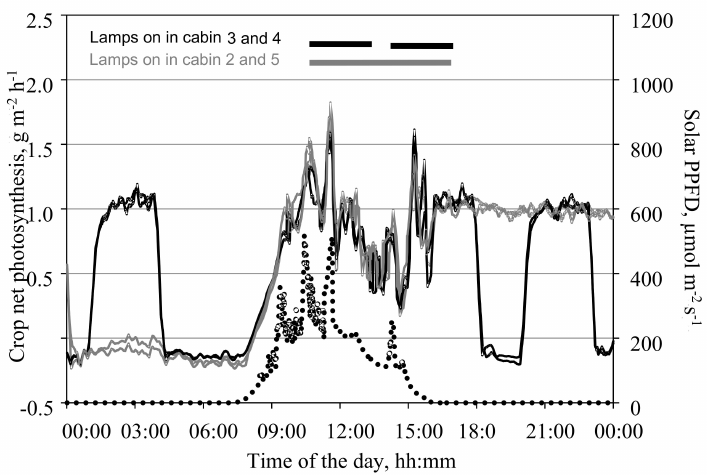
Figure 9. Daily course of net photosynthesis of a tomato crop measured in the open chamber mode and PPFD on the top of the crop on 24 November 2015 under two di ff erent light regimens. Data shows measurements taken in 9-min intervals. Leaf area index was 1.4 m 2 m − 2 . CO 2 concentration in the cabin air ranged between 500 µ mol mol − 1 during the dark and 350 µ mol mol − 1 during the light phases. In two cabins, artificial light of 210 µ mol m − 2 s − 1 PPFD was supplied from 15:00 to 24:00, while plants in two other cabins received artificial light of the same intensity from 15:00 to 18:00, 20:00 to 23:00 and 01:00 to